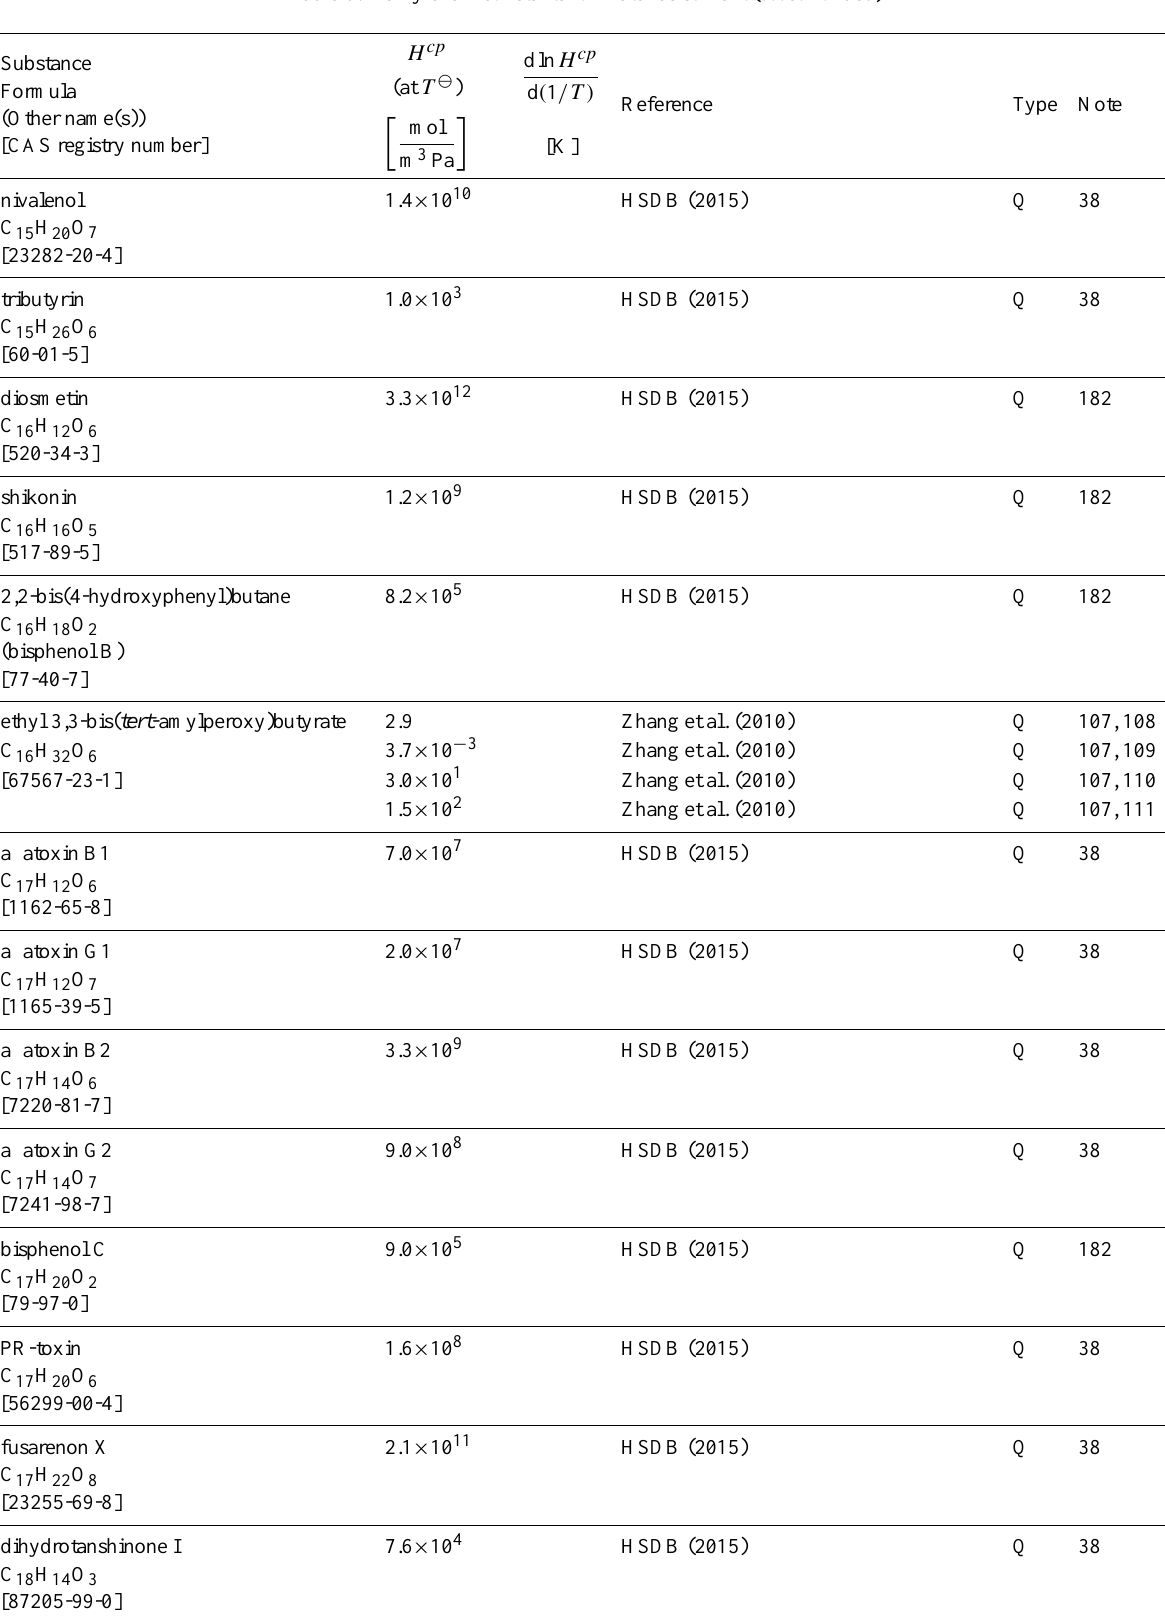
Table 6: Henry’s law constants for water as solvent